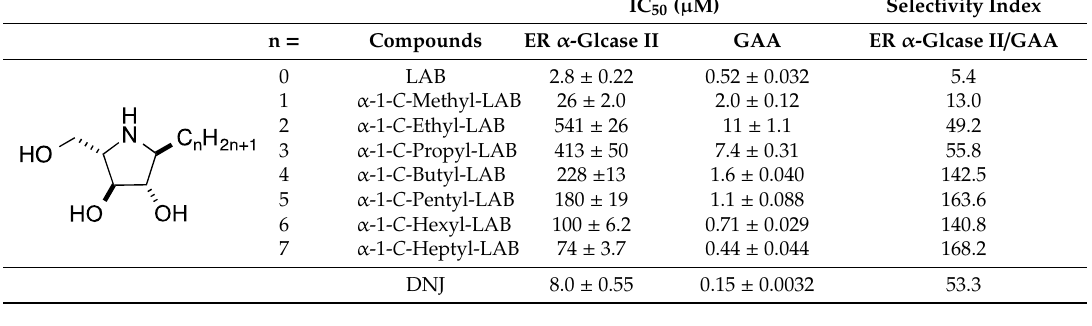
Table 1. IC 50 values (µM) for α -1- C -alkyl-LAB and related compounds against processing ER α -glucosidase II (ER α -Glaase II) and lysosomal acid α -glucosidase (GAA).